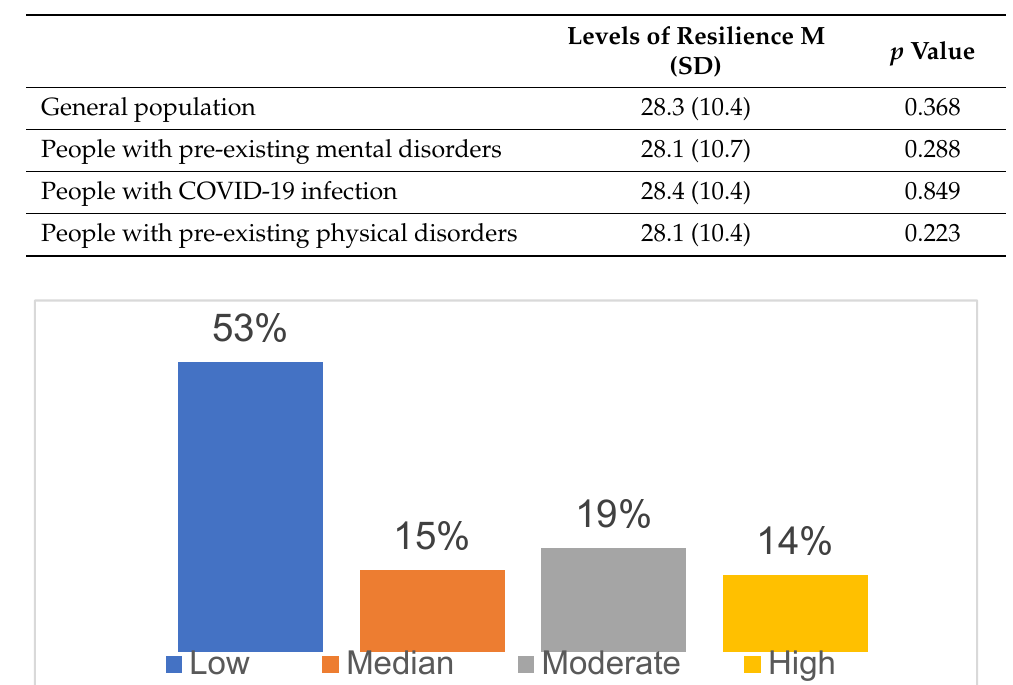
Table 2. Differences among groups in the levels of resilience.